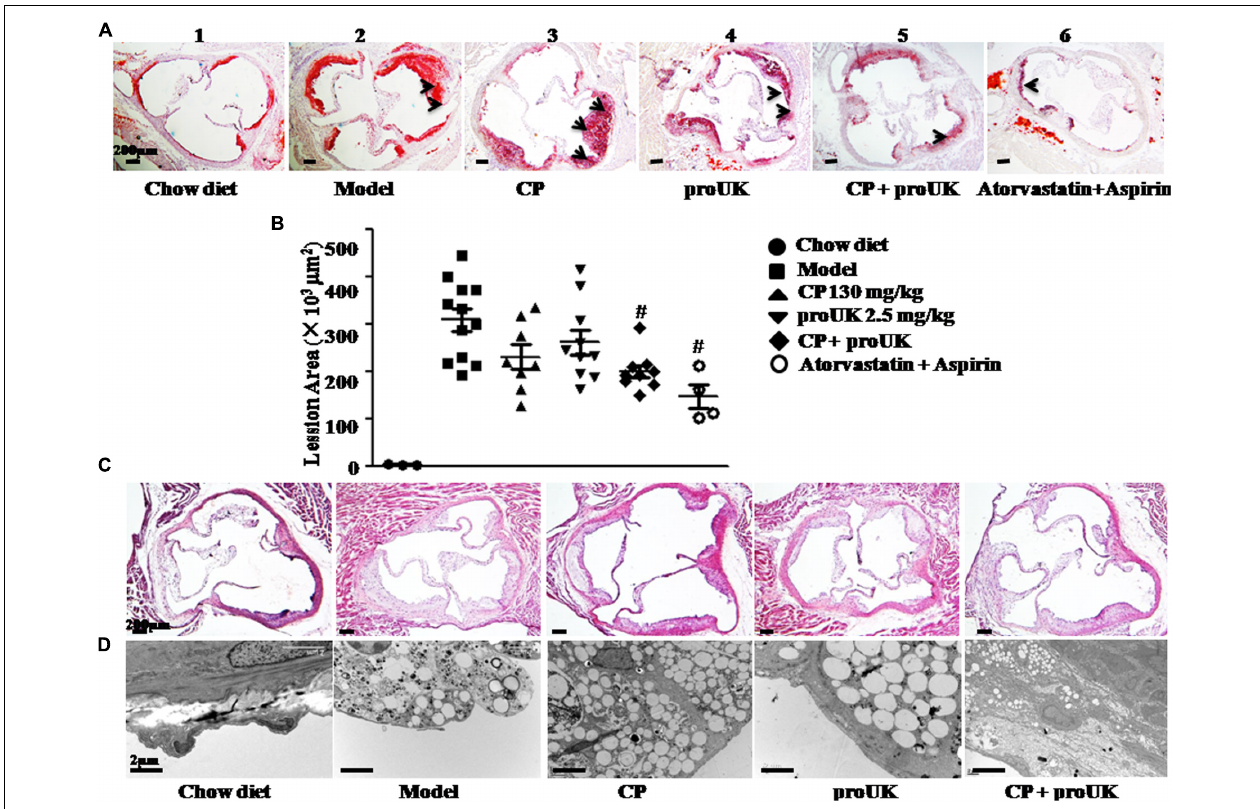
FIGURE 2 | CP plus proUK reduces atherosclerosis lesion area in aortic root of LDLR − / − mice. At the end of the treatment, aortic roots were prepared for transmission electron microscopy or as 7- µ m frozen cross sections and stained with HE or Oil Red O solution. (A) Oil Red O staining of the left ventricular outflow tract in LDLR − / − mice from Chow diet group (A-1) , n = 3, Model group (A-2) , n = 10, CP + HFD group (A-3) , n = 8, proUK + HFD group (A-4) , n = 10, CP + proUK group (A-5) , n = 8. Atorvastatin + Aspirin group (A-6) , n = 4, Bar = 200 µ m. The arrow shows the atherosclerosis plaque. (B) The statistic results of Oil Red O staining atherosclerosis lesions. n = 8–10. # P < 0.05 vs. Model mice. (C) HE staining of the left ventricular outflow tract in LDLR − / − mice from Chow diet group (B-1) , Model group (B-2) , CP + HFD group (B-3) , proUK + HFD group (B-4) , CP + proUK group (B-5) . Bar = 200 µ m. (D) Transmission electron microscopic images of the aortic arch in LDLR − / − mice from Chow diet group (C-1) , Model group (C-2) , CP + HFD group (C-3) , proUK + HFD group (C-4) , CP + proUK group (C-5) . Bar = 2 µ m.